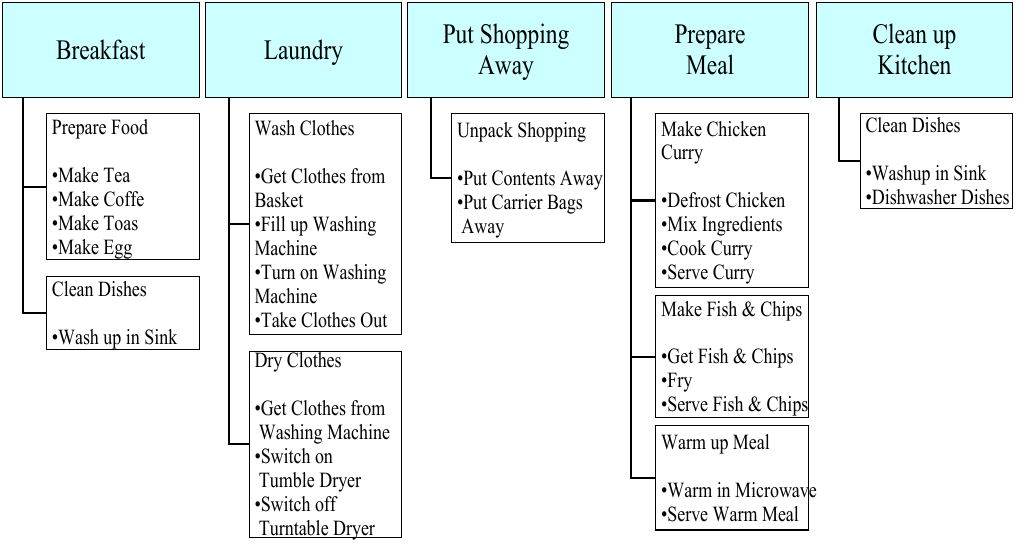
Figure 12. Hierarchical abstraction of ADL for